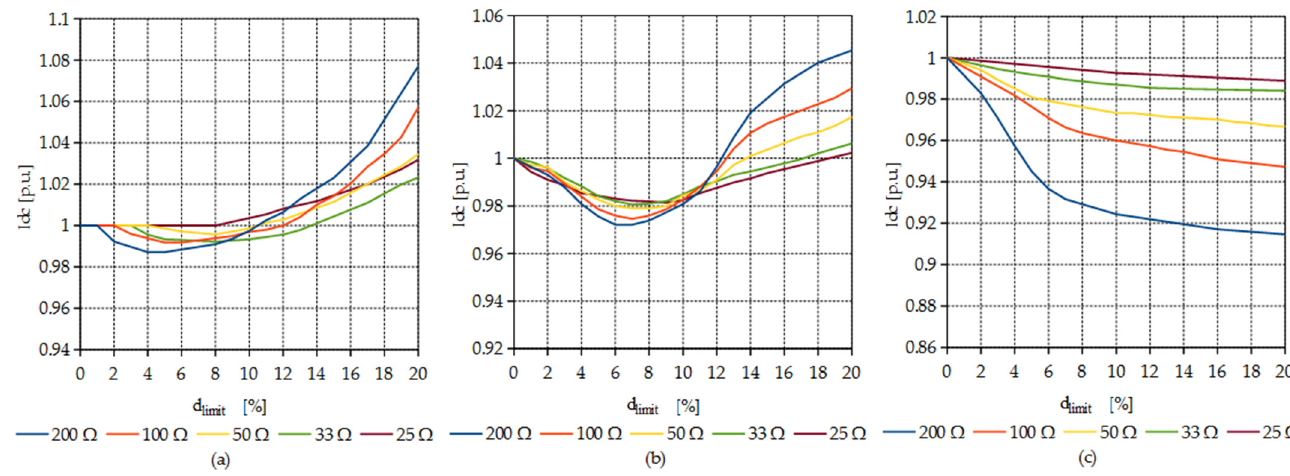
Figure 12. Relative input DC-link current measured at different load at ( a ) 1500 RPM, ( b ) 2000 RPM, and ( c ) 2500 RPM; I dc denotes the input DC-link